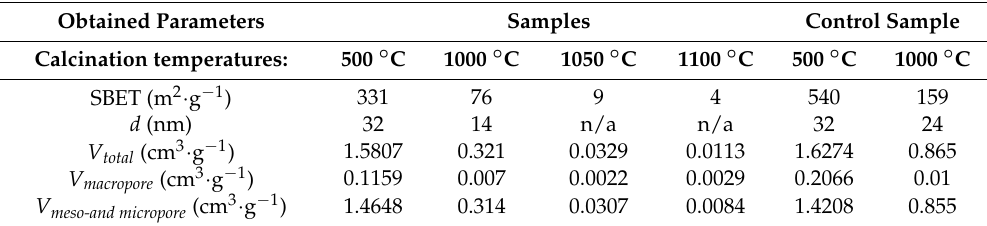
Table 1. Calculated parameters of the porosity of the samples. The specific surface area was obtained by the BET model, the pore size distribution and the pore volume were determined by the BJH method. Obtained Parameters Samples Control Sample Calcination